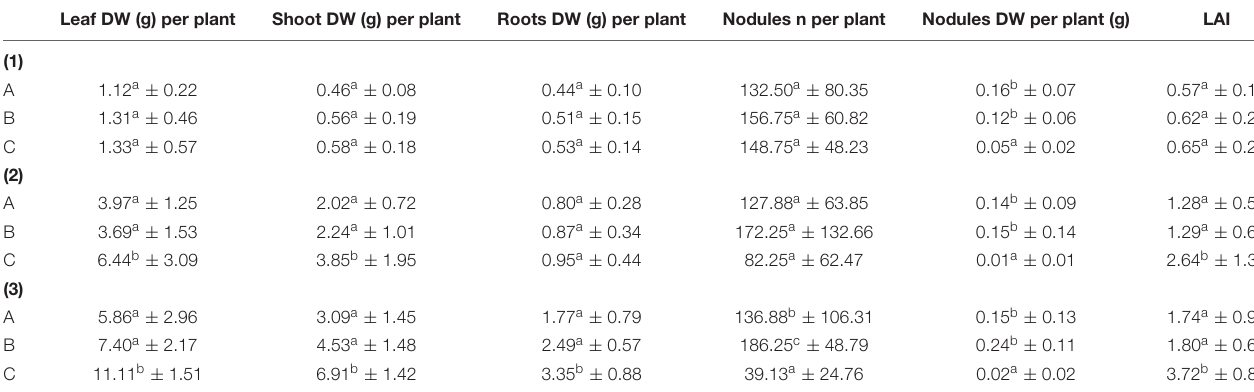
TABLE 1 | Results for the mean values ( n = 8) per plant of fresh weight (FW) and dry weight (DW) of the different organs as well as the Leaf Area Index (LAI) m 2 plant − 1 of the three treatments (A = 2g Struvite + Rhizobium; B = 5g Struvite + Rhizobium; C = Control) in three different time periods: 35 DAT (1), 62 DAT (2), and 84 DAT (3). Leaf DW (g) per plant Shoot DW (g) per plant Roots DW (g) per plant Nodules n per plant Nodules DW per plant (g)